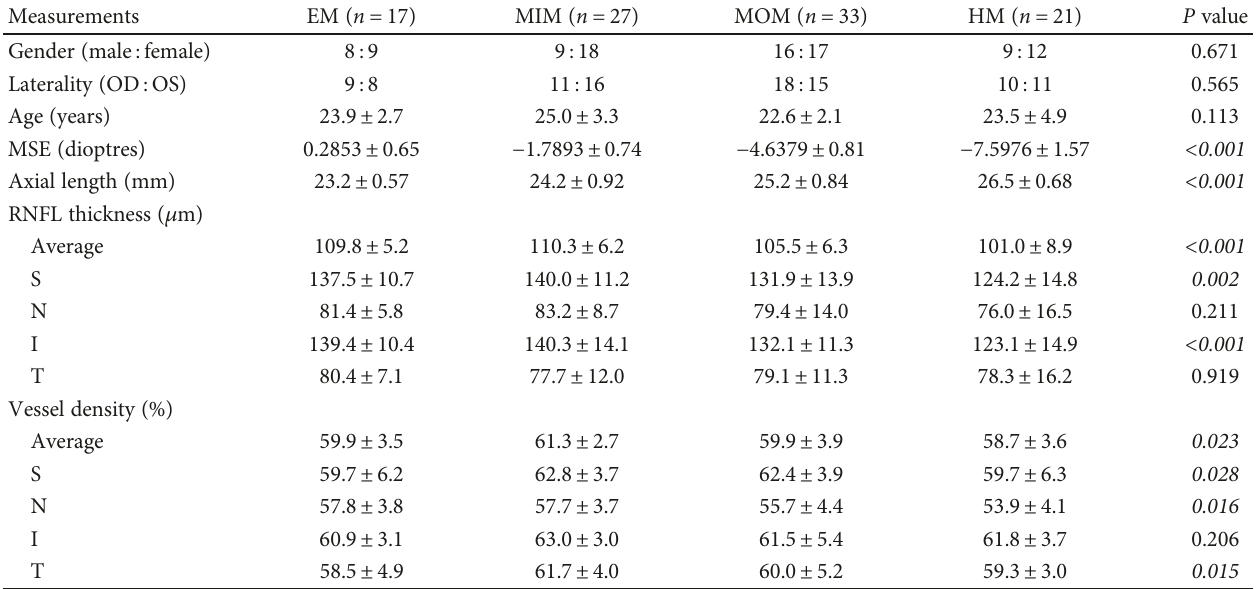
Table 1: Demographic and ocular characteristics of participants between the refractive groups.